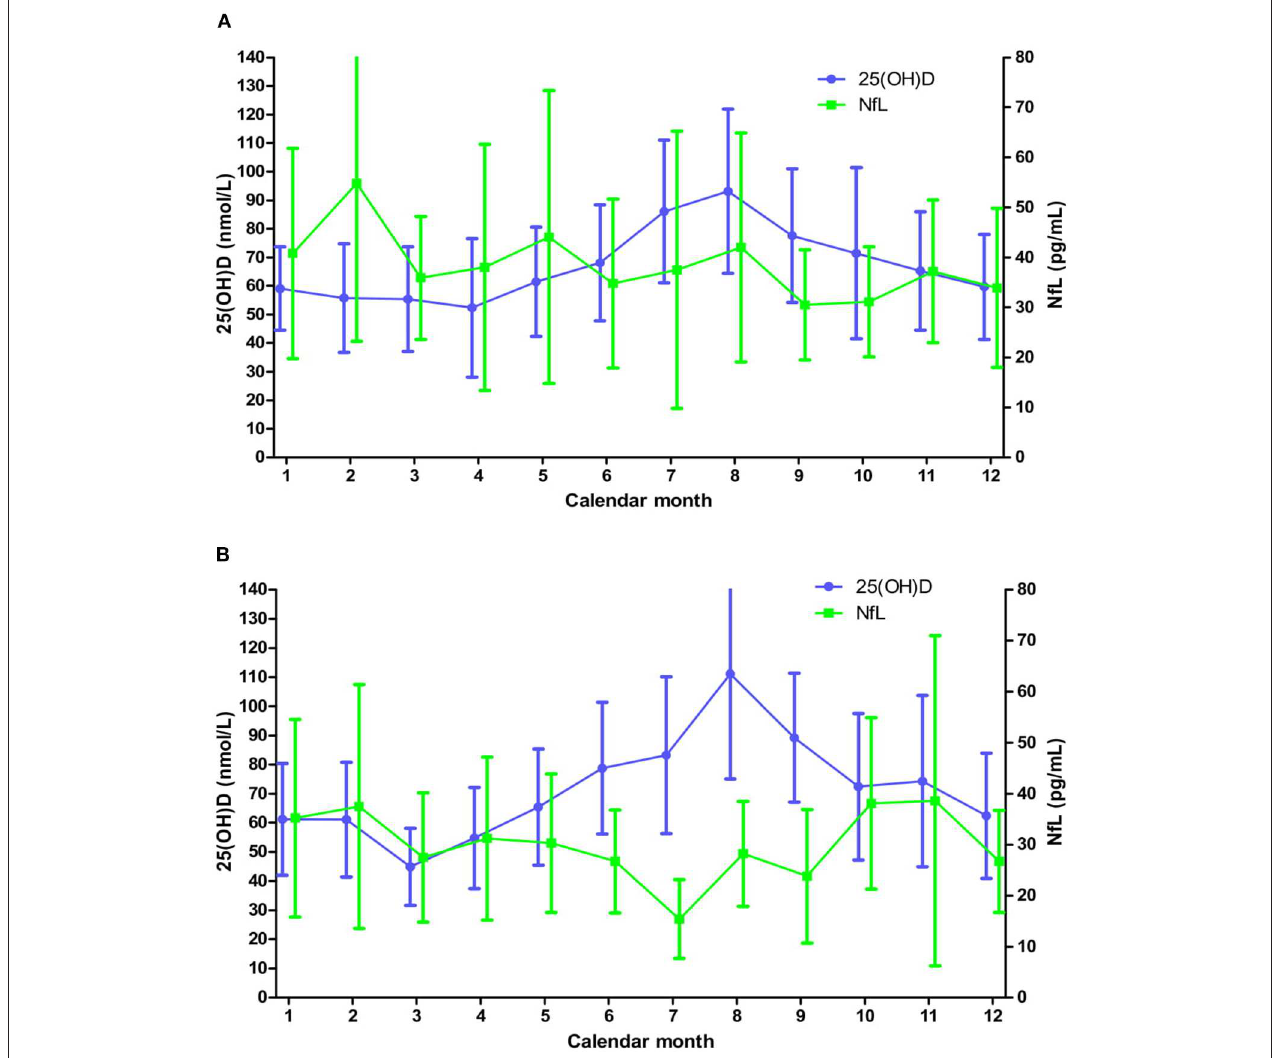
FIGURE 3 | Mean (SD) serum levels of 25(OH)D and NfL levels throughout the calendar year before (A) and during (B) IFN- β treatment. (A) Based on all available 25(OH)D and NfL measurements from a minimum of 14 and 10 patients, respectively, at each month. (B) Based on all available 25(OH)D and NfL measurements from a minimum of 18 and 2 patients, respectively, at each